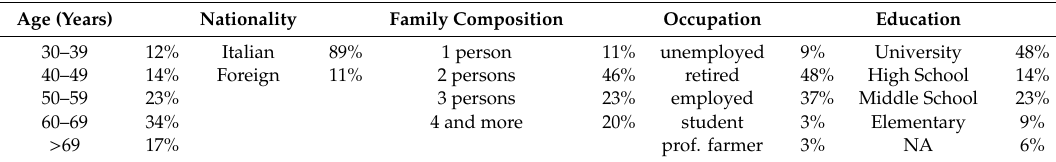
Table 3. Sociodemographic characteristics of the hobby farmer sample ( n = 35); % refers to the total per item.